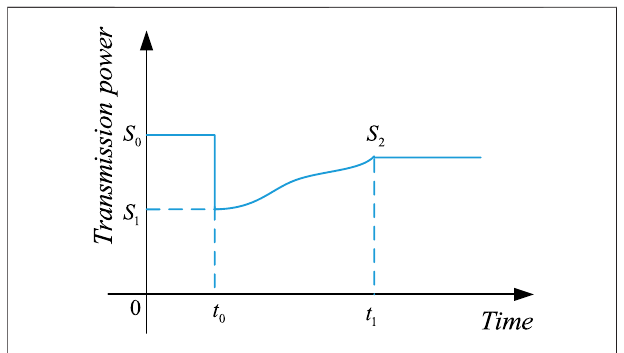
FIGURE 2 | Diagram of system power transmission